Question: In one sentence, what is this figure communicating?
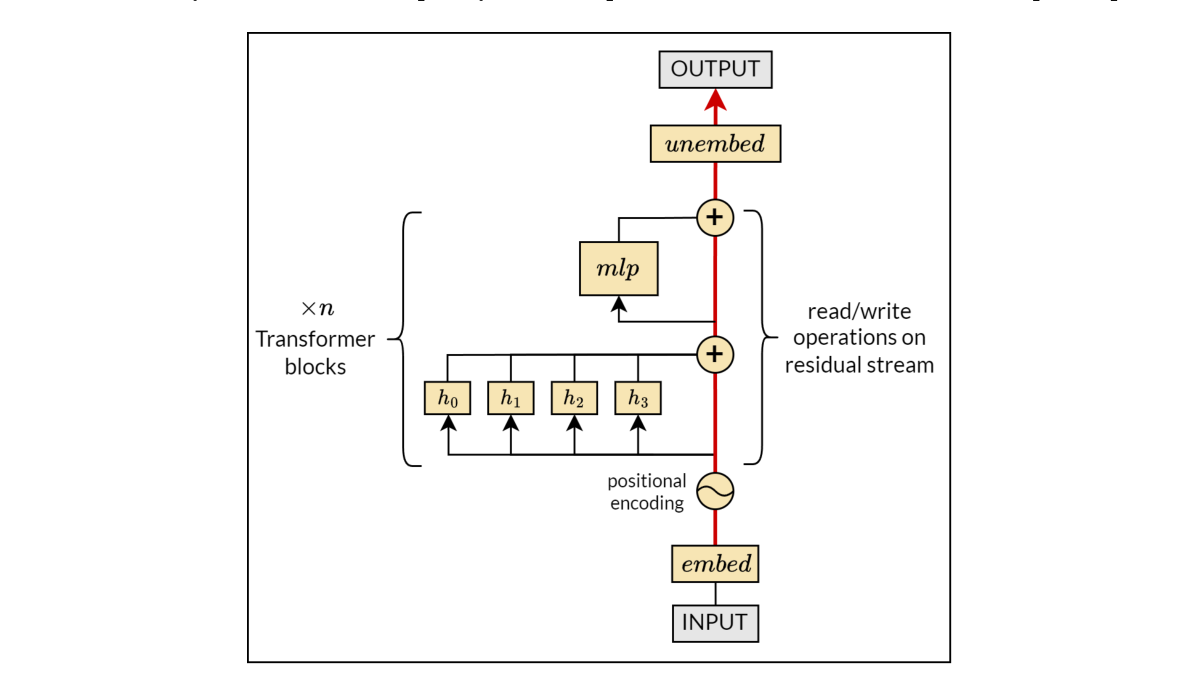
Answer: | The residual stream view of the Transformer. Each input token is first embedded into a dense vector representation and combined with a positional encoding injecting information about their position in the input sequence. This forms the initial state of the "residual stream" (depicted by the red arrow), which flows through the entire network. Each Transformer block, consisting of multi-head self-attention and a multi-layer perceptron (MLP), reads from the residual stream, transforms the representation, and writes the result back into the stream via residual connections. This process is repeated across multiple Transformer blocks. Finally, the output of the residual stream is ‘unembedded’ to map the transformed representation back to the original token space. In this view, the Transformer’s components are seen as operators that successively refine the residual representation.